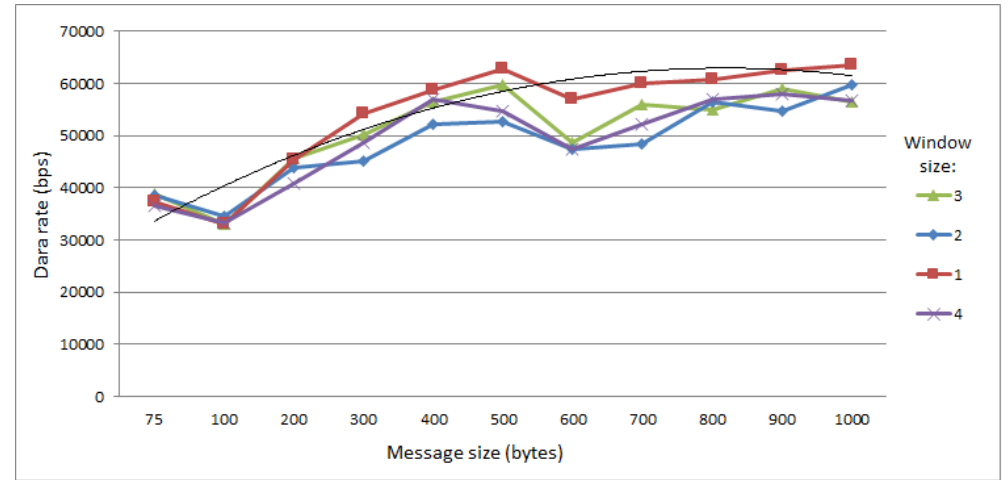
Figure 9. Data flow between mobile data collectors (MDC) and Sink.